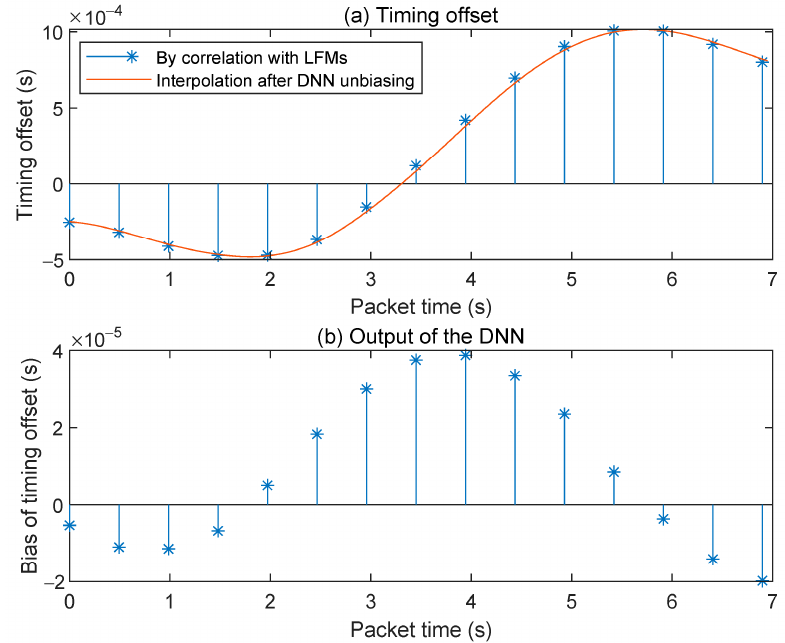
Figure 5. Timing offsets before and after interpolation ( a ) and the output of the DNN ( b ) in the vertical communication experiment.